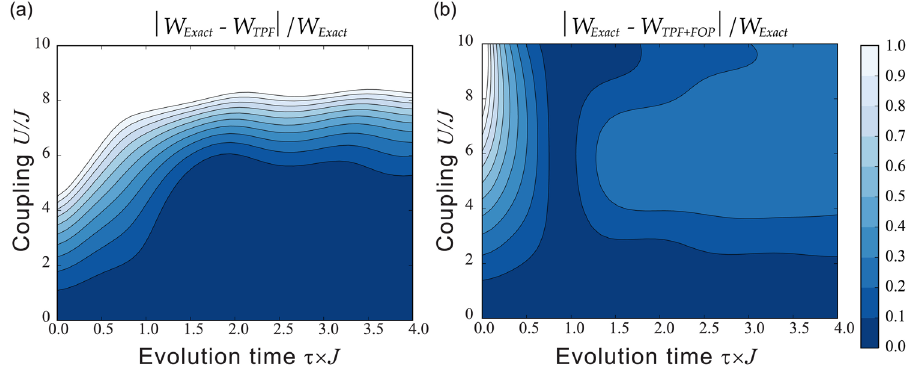
Figure 5. Contour plot of the relative error for the average extractable work when including time dependence of the functionals (TPF) describing many-body interactions. Data are presented with respect to the dimensionless coupling strength U / J and the dimensionless evolution time τ × J . (a) panel: without FOP; (b) panel: with